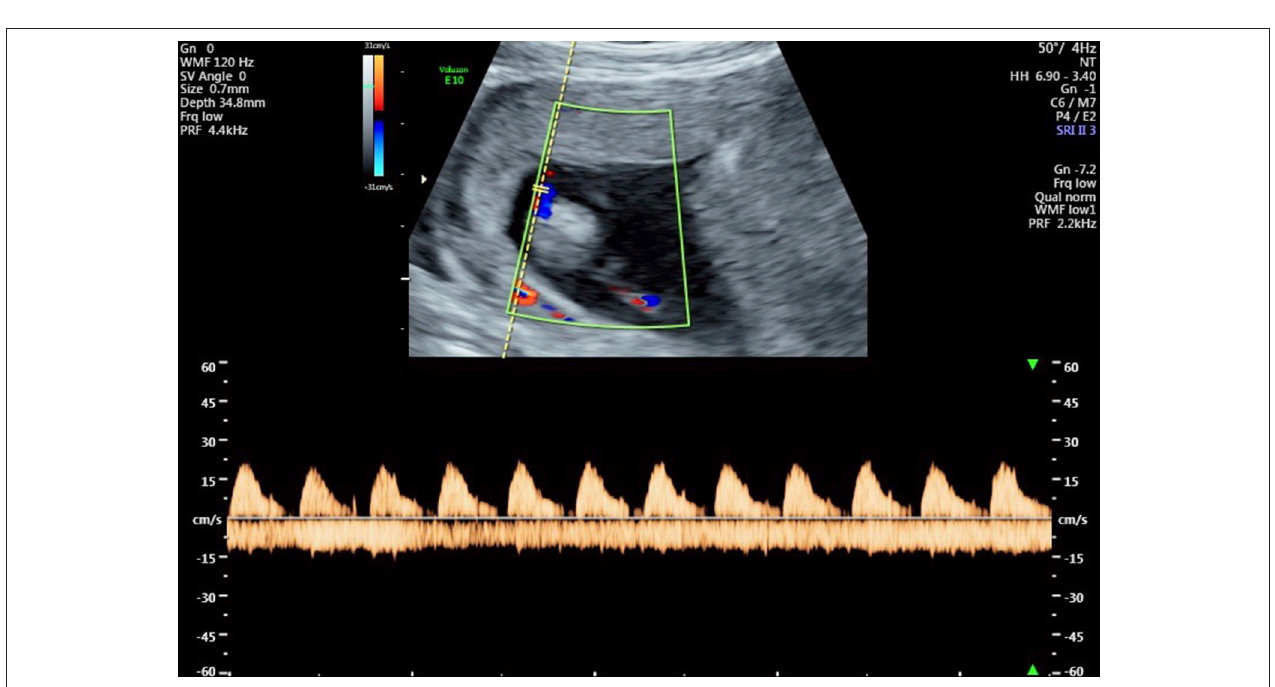
FIGURE 5 | Flow velocity waveforms from the umbilical artery at 13 weeks and 1 day showing partial end-diastolic flow. In some cardiac cycles there is flow throughout almost the entire diastolic phase, indicating a reduction in vascular resistance in the umbilico-placental vascular bed.